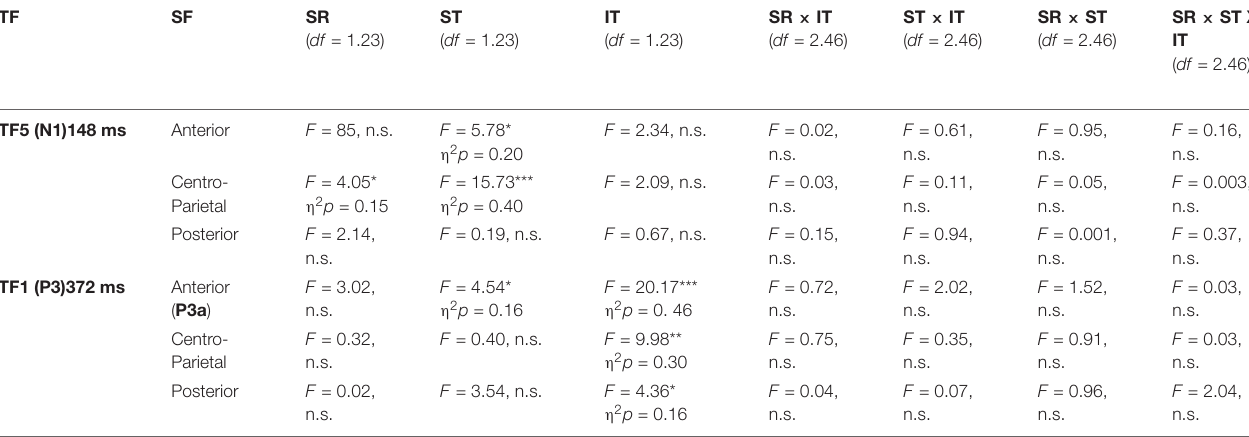
TABLE 2 | Repeated measures ANOVAs for each spatial factor (SF: Anterior, Centro-Parietal, Posterior) of the two temporal factors (TF: N1, and